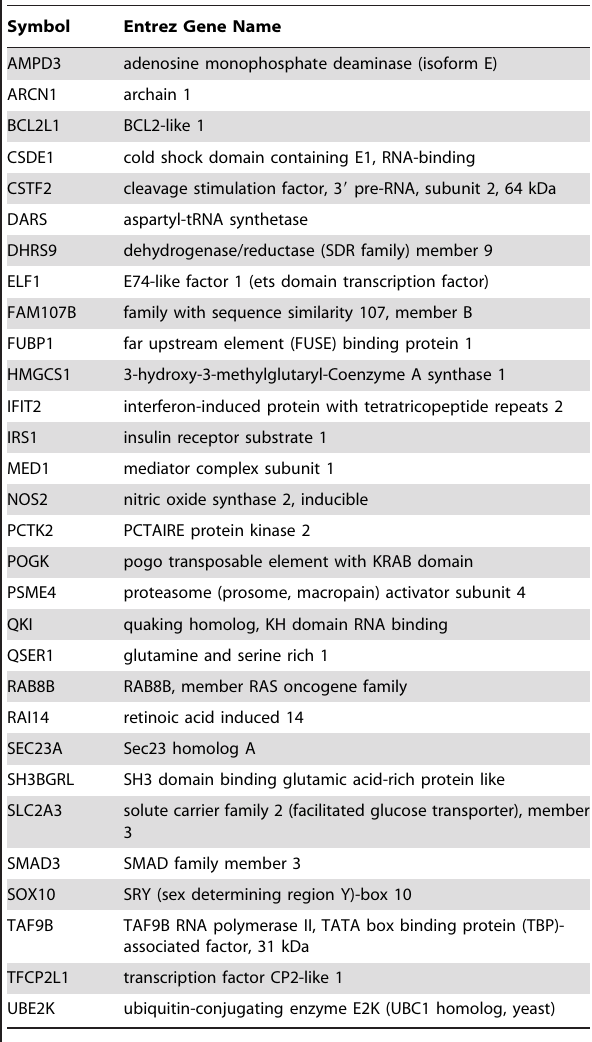
Table 5. Analysis of genes dysregulated by over-expression, or knock-down, of miR-146a in LPS stimulated EOC 13.31 cells using either miRNA mimics or